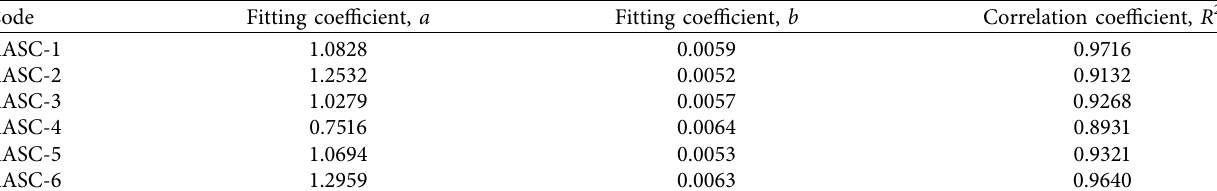
Table 15: Relative dynamic elastic modulus accumulative damage exponential function and pertinence